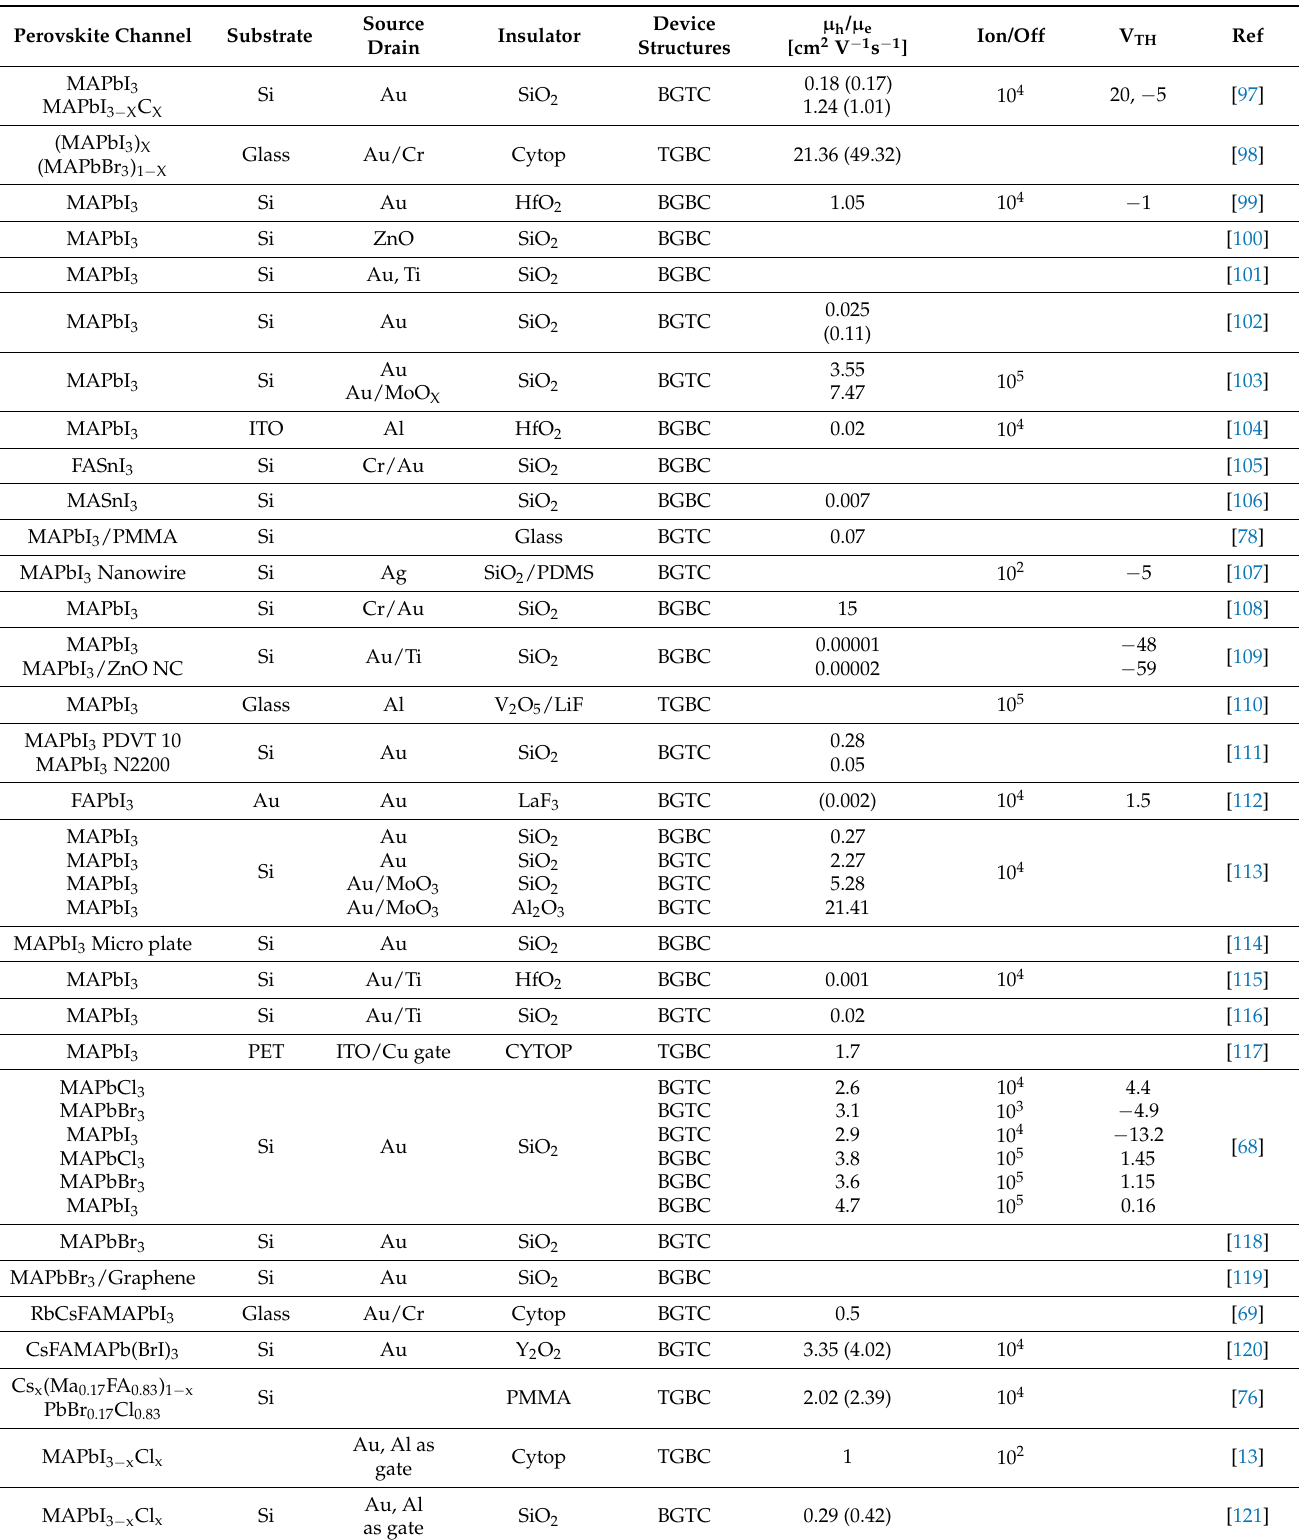
Table 2. The single hybrid organic–inorganic perovskite structured material channel based thin-film FET works in the literature after